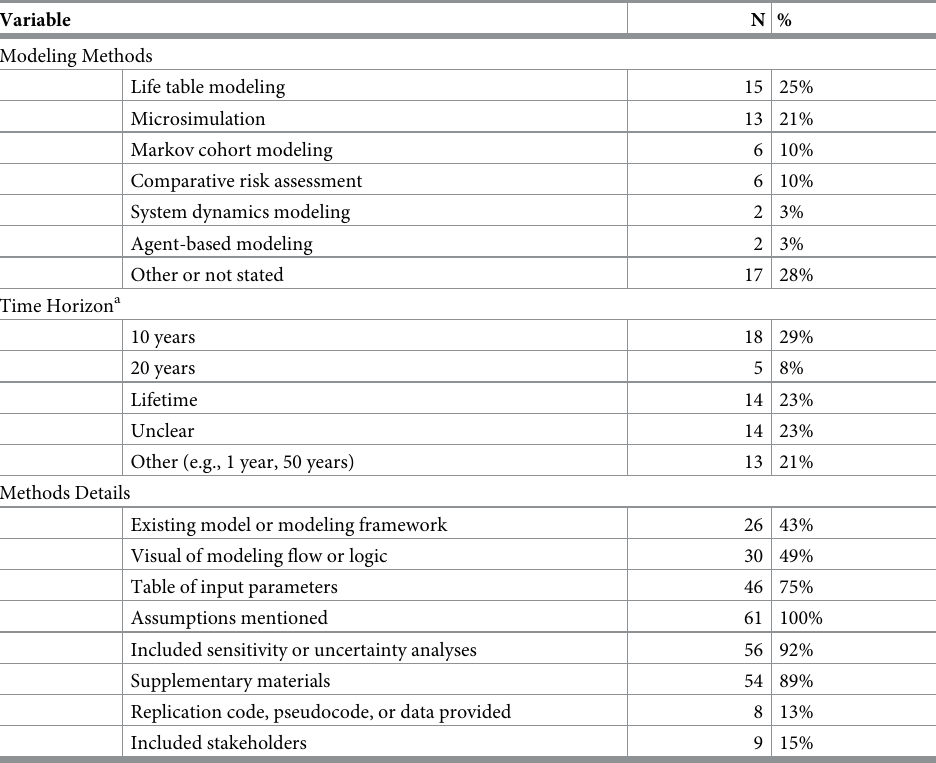
Table 2. Modeling methods of included studies (n = 61).